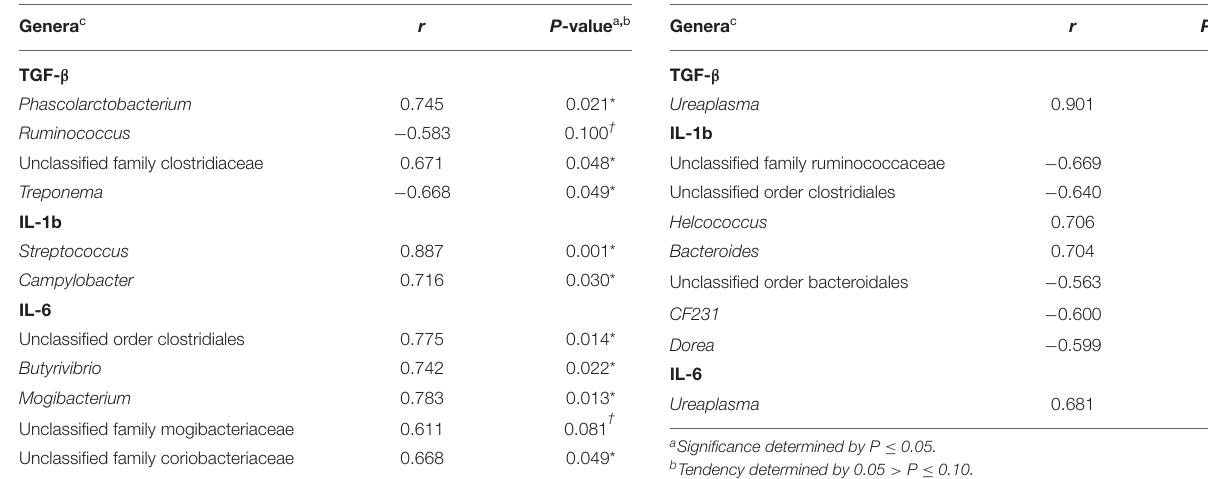
TABLE 3 | Pearson correlation coefficients ( r ) for TGF- β , IL-1b, and IL-6 and the relative abundance of genera within the uterus of resulting pregnant cows for d −